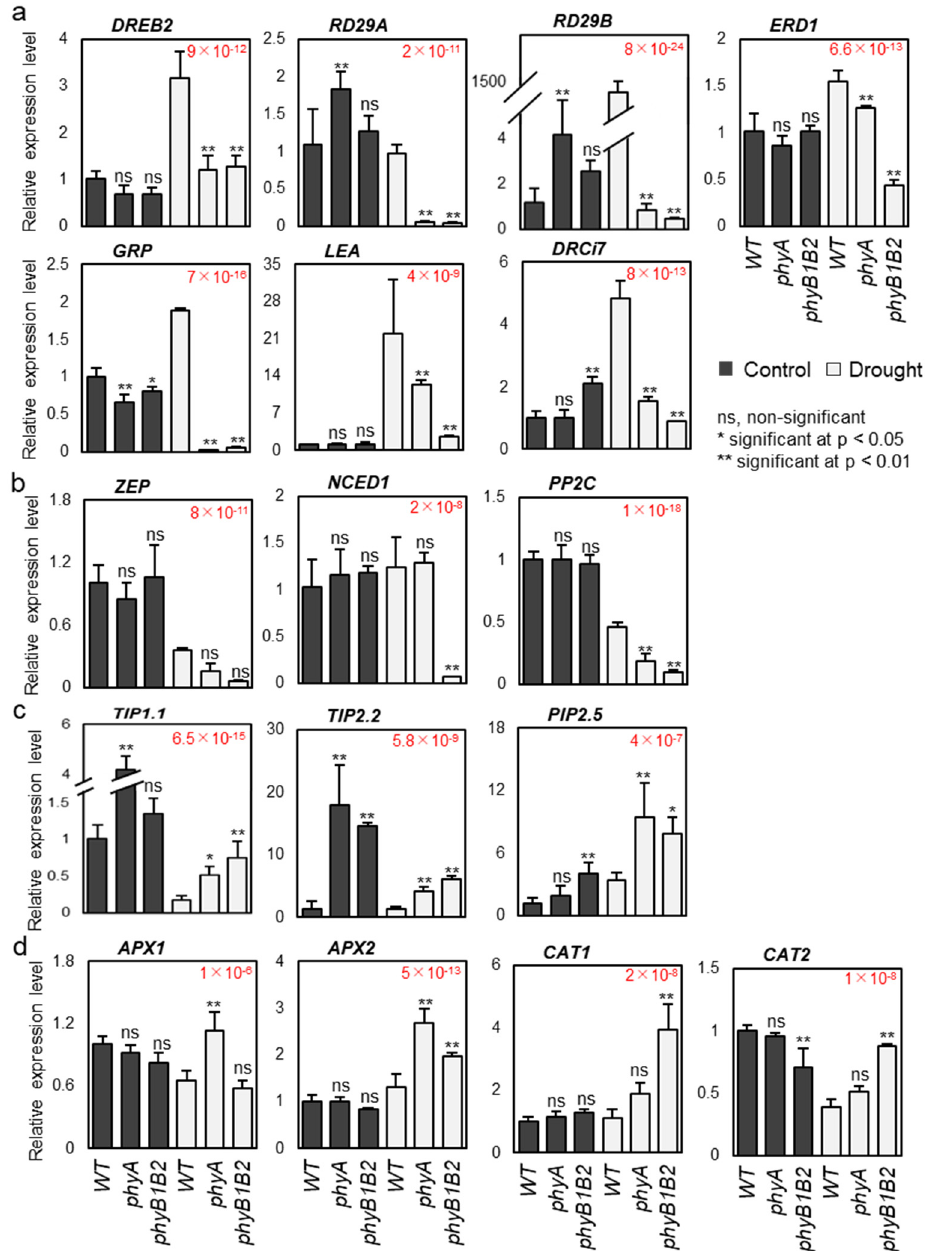
Figure 5. The molecular response of WT, phyA , and phyB1B2 plants. The expression levels of drought-related genes in one-month-old plants after 8 days (d) of water withholding compared to under non-stress conditions. Drought-responsive genes: DREB2 , RD29A , RD29B , ERD1 , GRP , LEA , and DRCi7 ( a ). ( b ) Abscisic acid (ABA)-responsive genes: ZEP, NCED1, and PP2C. ( c ) Aquaporin genes: TIP1;1 , TIP2;2 , and PIP2;5 . ( d ) Reactive oxygen species (ROS) scavenger genes: APX1 , APX2 , CAT1 , and CAT2. The results of the relative expression level of WT under non-stress conditions were normalized to 1. Data represent the mean and standard error values of a minimum of three replica- tions. Statistically significant differences are represented by one asterisk for p < 0.05 and two aster- isks for p < 0.01, whereas ns indicates statistically non-marked differences between WT, phyA , and phyB1B2 under non-stress and drought-stress conditions, in accordance with a post hoc Tukey HSD test with ANOVA. The ANOVA p -values are shown in red. Additionally, the p -values of the post hoc test are presented in Supplementary Materials (Table S3).